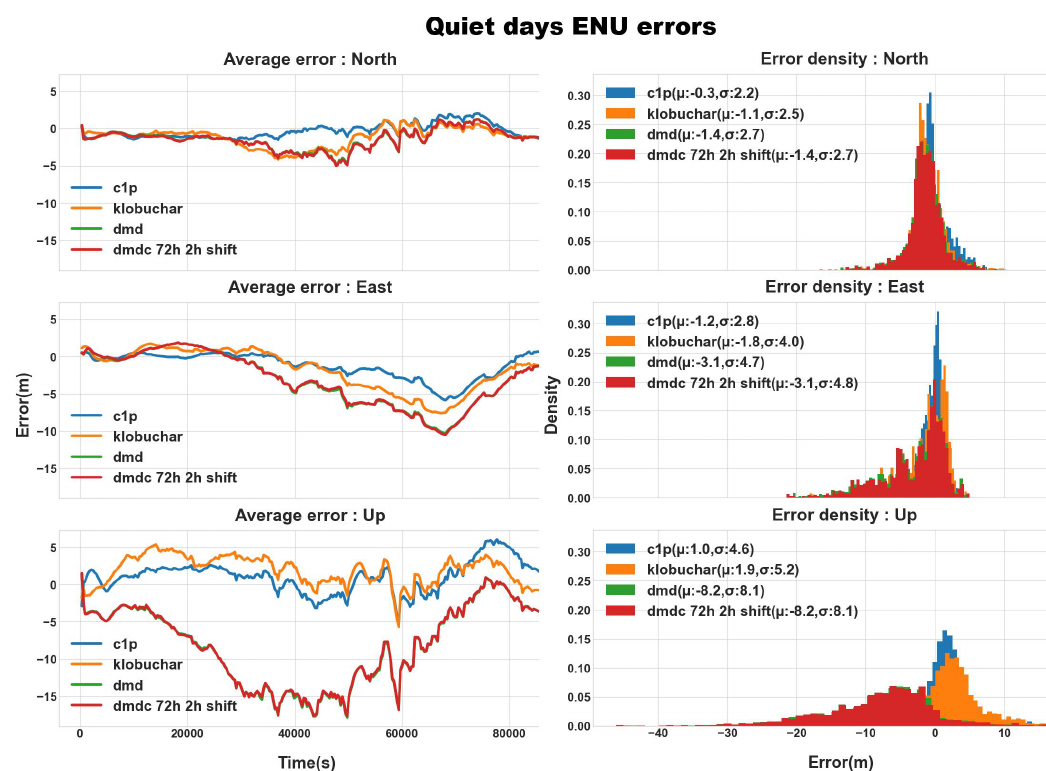
Figure 8. ENU statistics of ten quiet solar days, estimated by the gLAB software for L1 single frequency using different Ionospheric correction sources. Left column shows the average error as a function of time. Right column shows the error distribution. Table 3. ENU errors [m] statistics over all time candidates and case studies, sorted by different solar activity periods and error